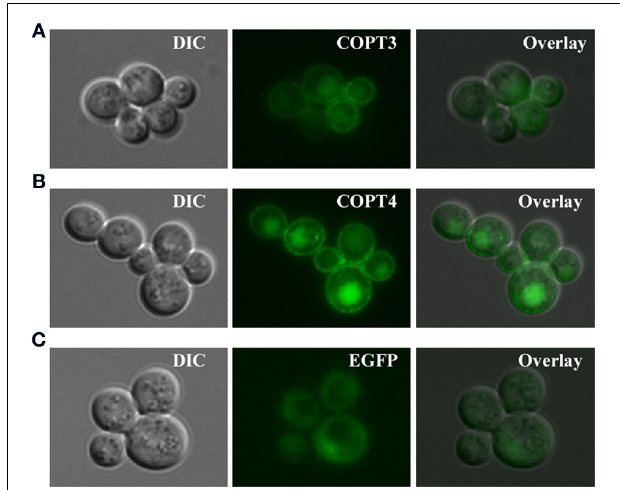
FIGURE 5 | Subcellular localization of BdCOPT3-EGFP (A) or BdCOPT4-EGFP (B) fusions or EGFP (C) in S. cerevisiae ctr1 (cid:2) ctr2 (cid:2) ctr3 (cid:2) cells. Superimposed images (Overlay) from differential interference contrast microscopy (DIC) and EGFP-mediated fluorescence